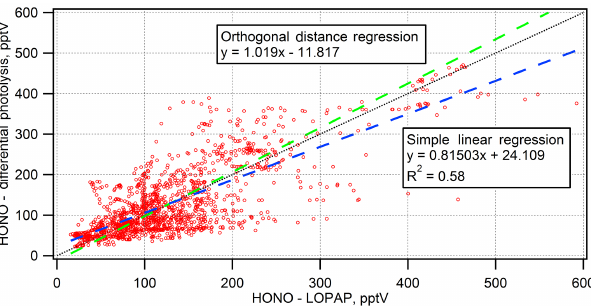
Figure 7. Correlation between HONO measured by LOPAP ( x axis) and pHONO ( y axis). The simple linear regression is shown in blue, and the orthogonal distance regression in green. The 1 : 1 line is shown for